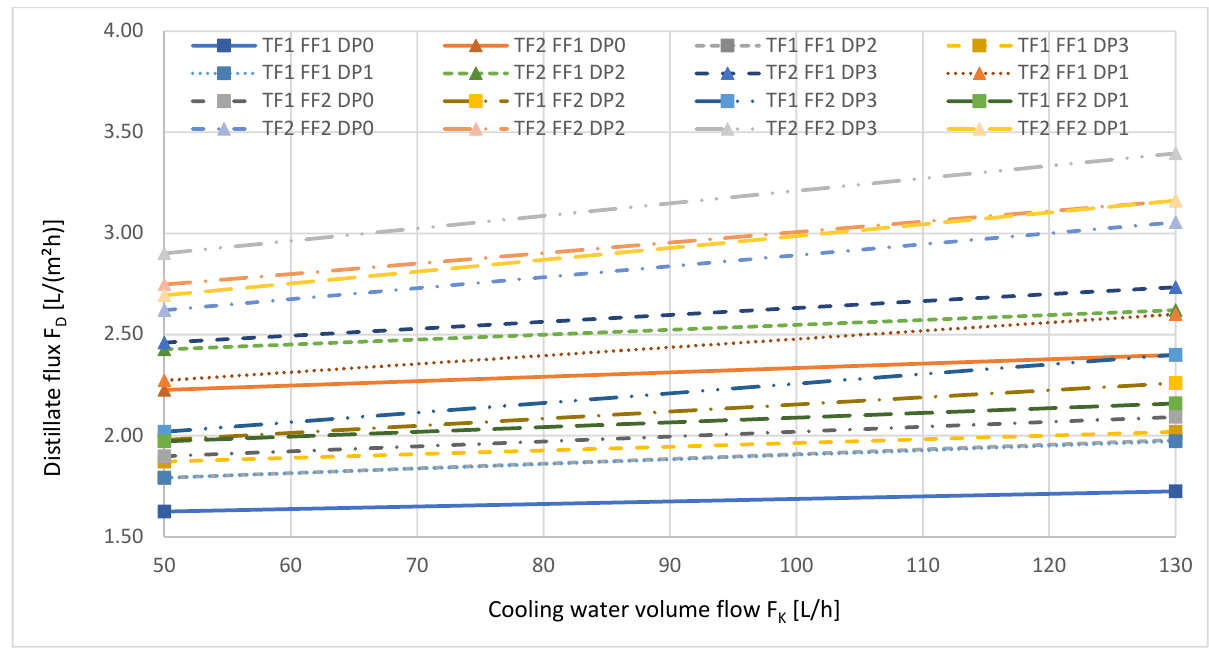
Figure 10. Distillate flux as a function of the volume flow of the cooling water F K during VMD. Δ p = const., F F = const., T K = const. during the respective measurement series. The numbers refer to the different reference levels, without pressure (0), low (1), medium (2) and high (3), reported in Table 4.